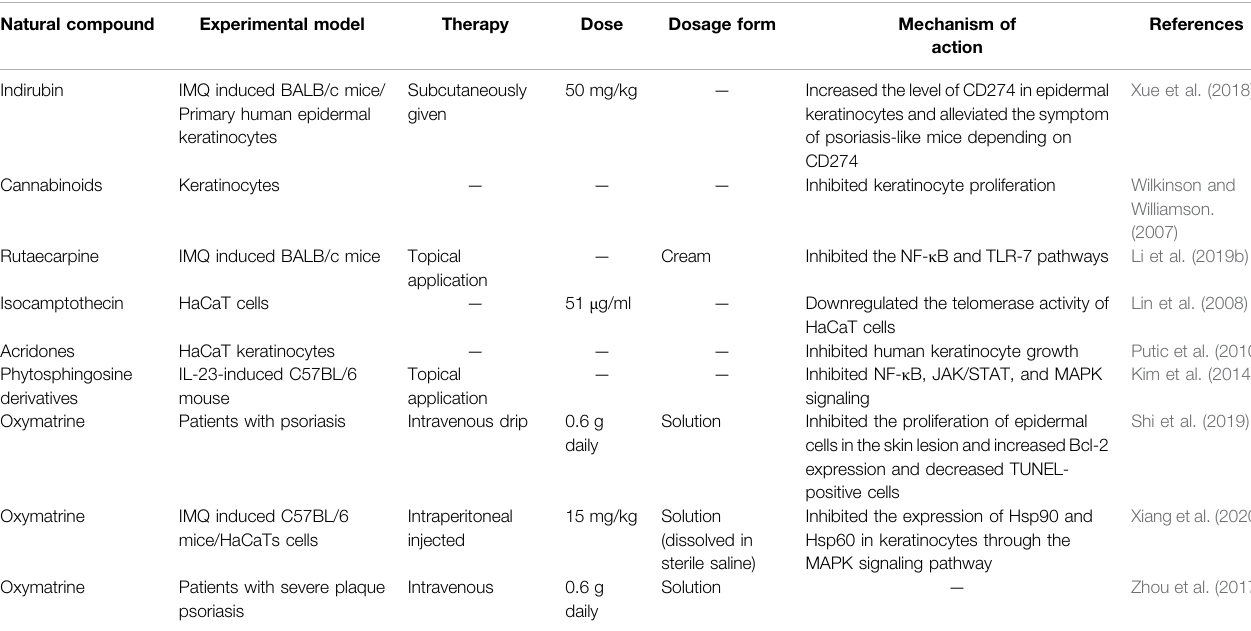
TABLE 4 | Alkaloids for the treatment of